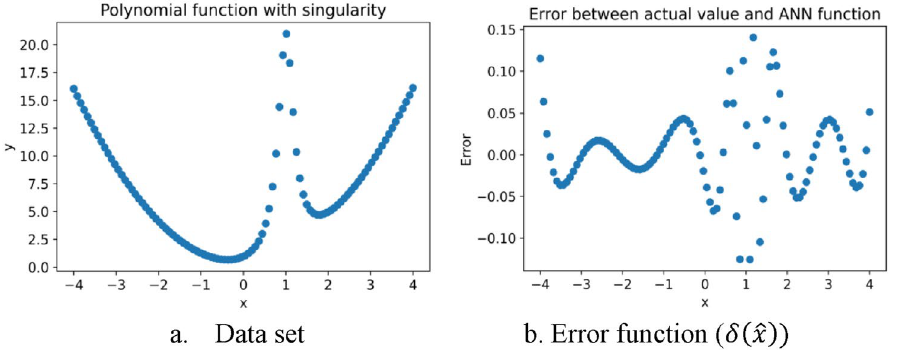
Fig. 5 Data set and error function of Polynomial function with